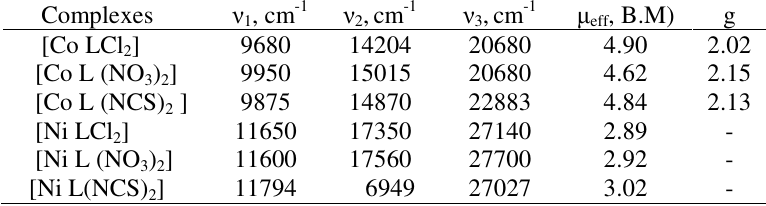
Table 2 . Electronic , EPR spectral and magnetic moment data of cobalt(II) and nickel(II)